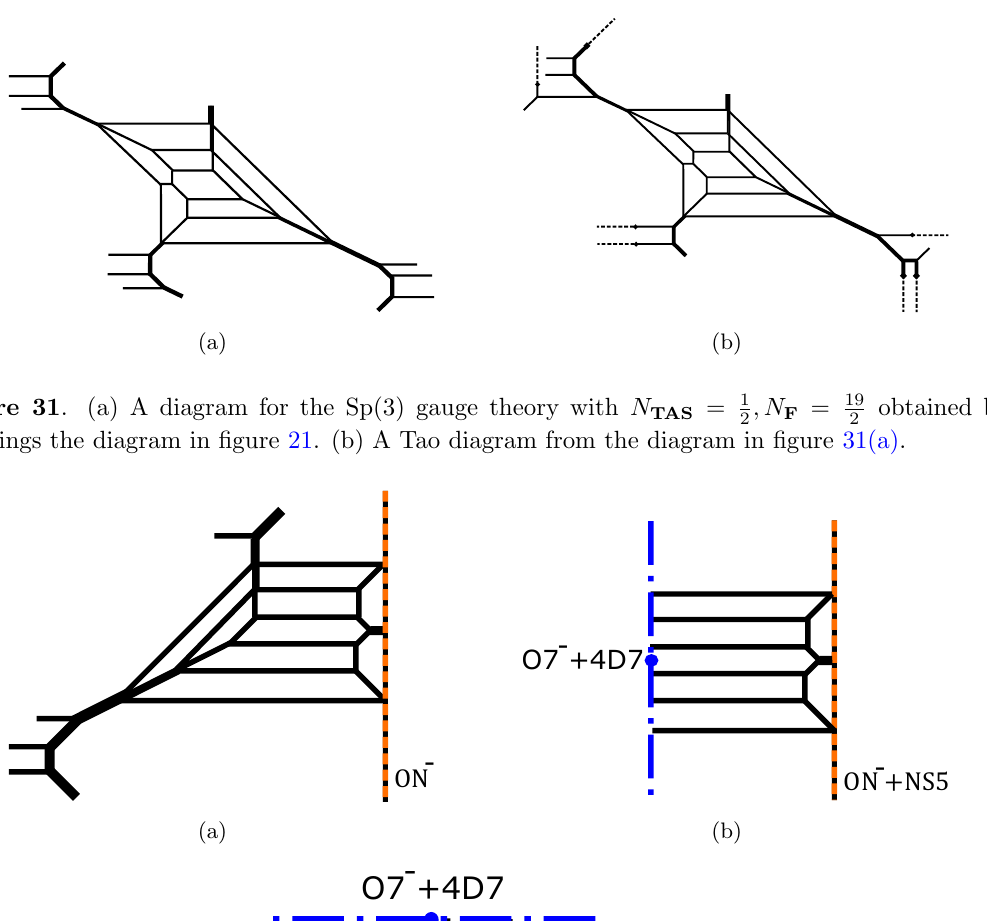
Figure 32 . (a) A diagram for the Sp(3) gauge theory with N TAS = 1 ; N F = 5 obtained by Higgsings the diagram in (cid:12)gure 17. (b) The diagram after forming an O7 (cid:0) -plane from the diagram in (cid:12)gure 32(a). (c) S-dual of the diagram in (cid:12)gure 32(b), exhibiting a periodic direction in the vertical